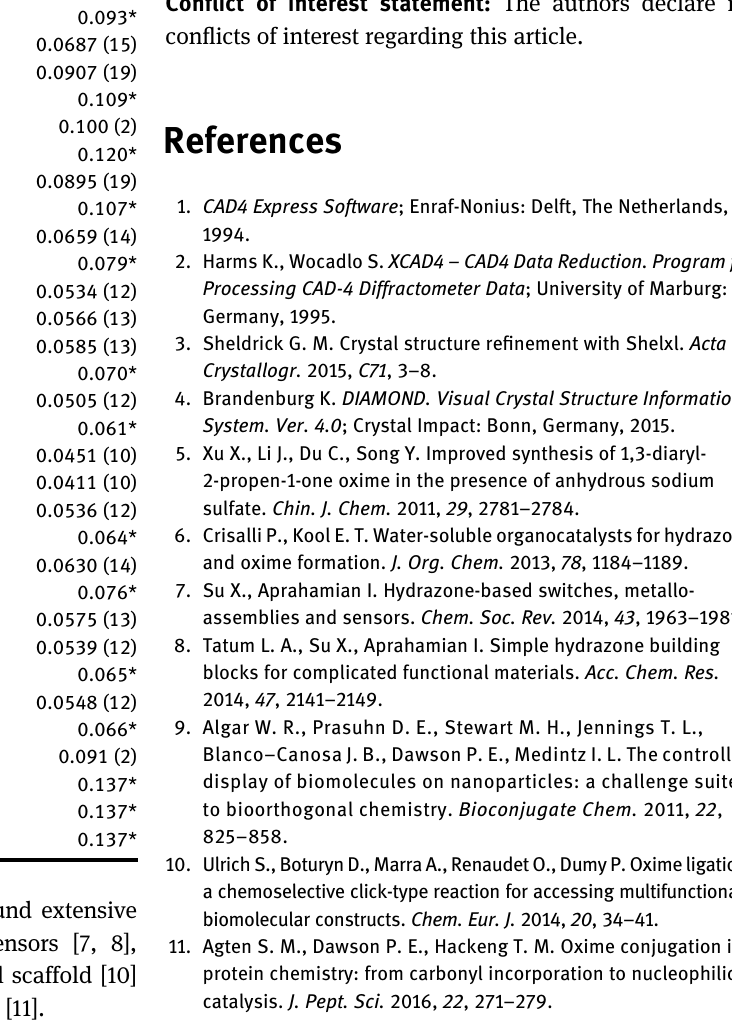
In the structure, the neighboring AMPO molecules associate through non-classical C24 – H24 ⋯ O2 hydrogen bonds forming a chain along the b axis. Furthermore, the two chains are associated through O2 – H2 ⋯ N hydrogen bonds forming a 2D structure. The anthracene rings form a sliped arrangement with a centroid – centroid distance of 5.365 Å indicating no π – π interaction between neigh-